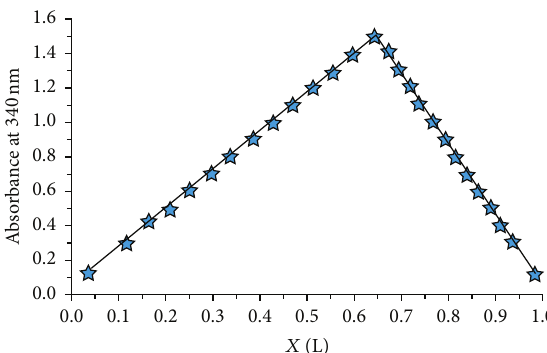
Figure 6: Job’s plot measurements of zinc-diosmin complex.